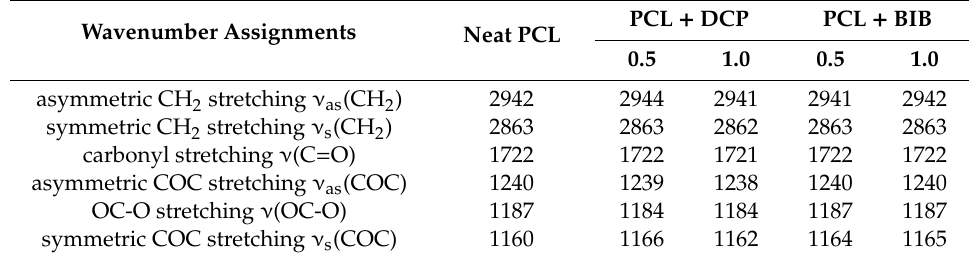
Figure 9. FTIR absorption spectra of PCL modified by DCP ( a ) and PCL modified by BIB ( b ). Table 5. Characteristic FTIR peak of the neat PCL and modified by peroxides.